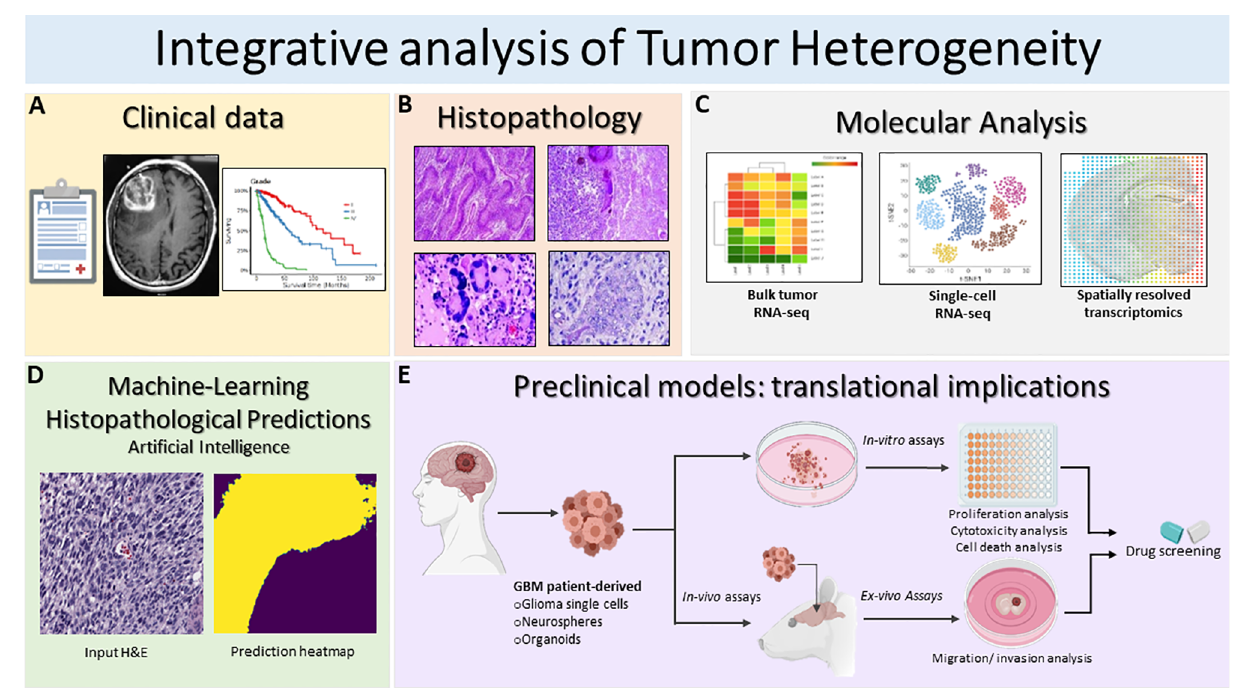
FIGURE 2 | Schematic illustration of the integrative translational preclinical and clinical work fl ow for translational implications. (A) First, clinical information is collected including the MRI and speci fi c glioma grade type. (B) Following surgery, neuropathological studies are used for both histopathological assessment and investigation of intratumoral heterogeneity. The histopathology images in Figure 2B are modi fi ed from Figures 1.34A, 1.35A,B, 1.41A in Chapter 1 Astrocyte Tumors, in IARC, and Otmar D. Wiestler. WHO Classi fi cation of Tumours of the Central Nervous System: WHO Classi fi cation of Tumours of the Central Nervous System (4th Edition), edited by David N. Louis, World Health Organization, 2006 (120). (C) Next, multiregional studies of the surgical samples can be harnessed to determine molecular targets within GBM employing bulk RNA-seq, scRNA-seq and spatially resolved transcriptomics. scRNA-seq method examines heterogeneity at very detailed resolution. The precision treatments are assessed according to tumor heterogeneity evaluation and potential pharmacological sensitivities. (D) Prediction of histopathological features based on a novel arti fi cial intelligence analysis of histological data will further aid clinical decisions. Furthermore, intratumoral heterogeneity assessment based on advanced imaging and machine-learning predictions should be carried out to monitor spatio-temporal heterogeneity dynamically and treatment. (E) GBM patient derived glioma cells, neurospheres and organoids can be exploited for preclinical modeling and perform pharmacological drug screening using in-vitro and ex-vivo assays. Patient derived organoids model the parental tissue and can be used to complement standard molecular pathology to understand mechanisms of resistance and can be applied to numerous functional assays such as: tumor cell survival, proliferation and self-renewal, and ex-vivo invasion/migration assays to identify pharmacological agent to target glioma invasion. Integrative GBM analysis attempts to improve predictive outcomes and treatments for